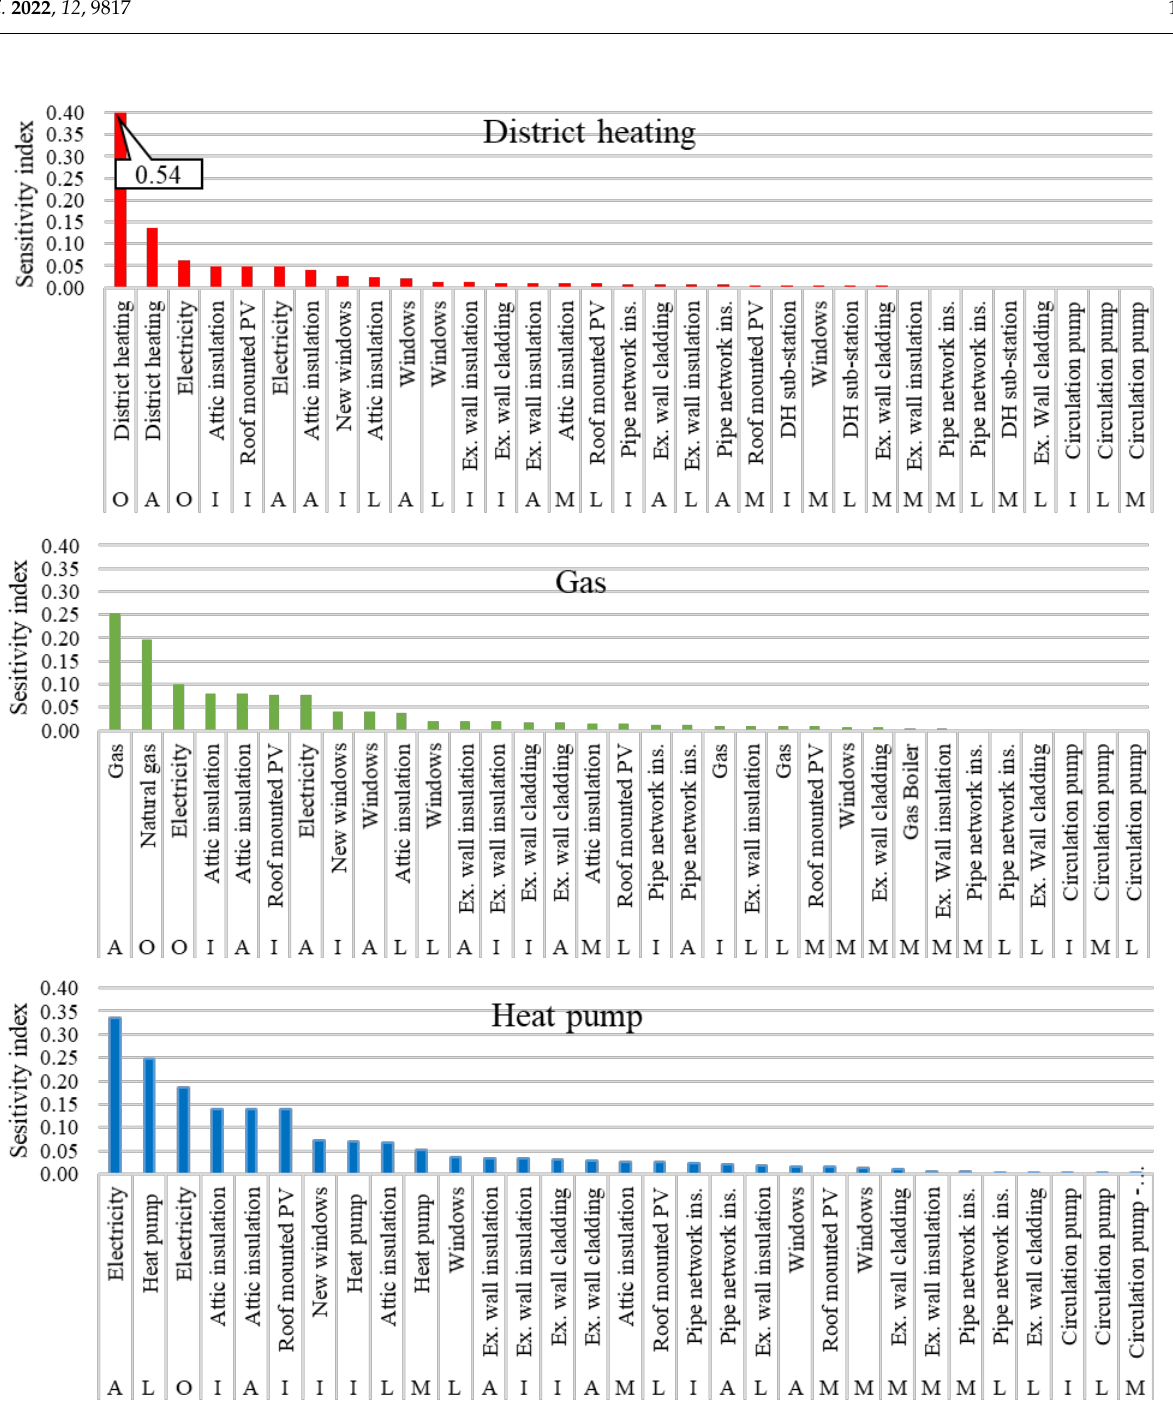
Figure 5. Results from variating input parameters using OAT approach. Capital letters represent the input category: O — operation, I — implementation, M — maintenance cost, L — lifetime (years), input category: O—operation, I—implementation, M—maintenance cost, L—lifetime (years), and and A — amount (kWh, m 2 , m 3 , etc.). A—amount (kWh, m 2 , m 3 ,